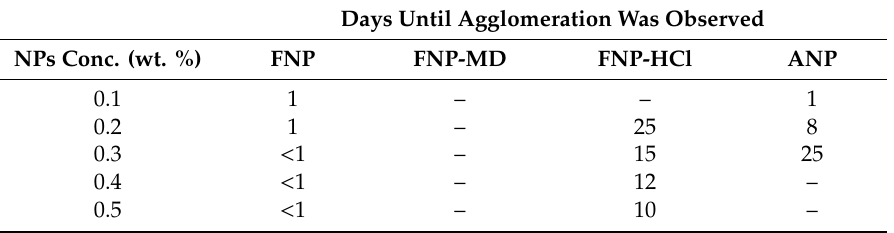
Table 4. Nanoparticles stability screening test.